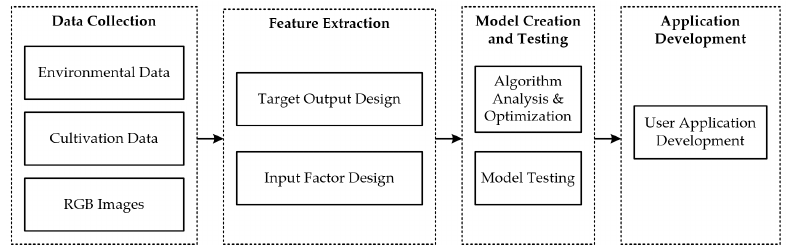
Figure 2. Conceptual framework of the Wondercane model.